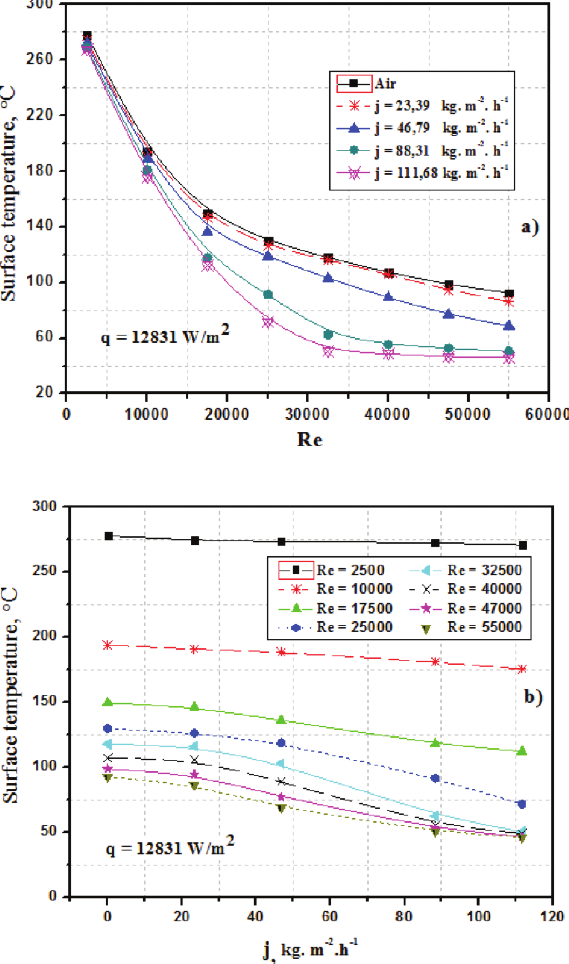
Figure 3. Evolution of surface temperature depending on the Reynolds number (а) and on the density of liquid phase (water) flow in the mist (b).